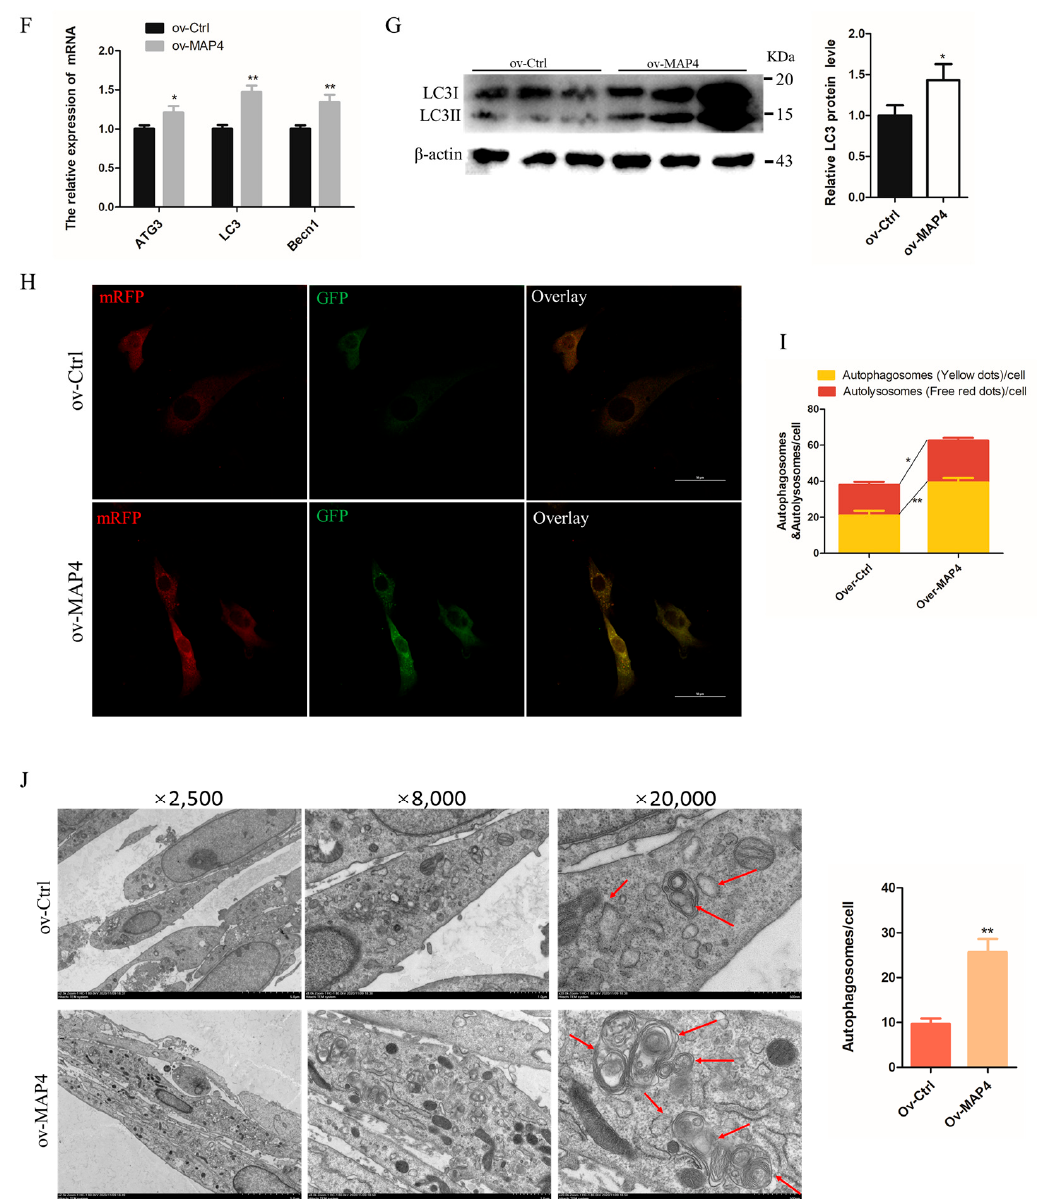
Figure 6. MAP4 induced autophagy of C2C12 cells. ( A , F ) ATG3 , LC3 , and Becn1 expression levels in C2C12 cells were determined at 24 h after MAP4 knockdown or overexpression. n = 3. ( B , G ) The protein expression of LC3 was determined by western blot at 48 h after MAP4 knockdown or overexpression. β -Actin was used as endogenous control. n = 3. ( C , H ) The autophagosomes and autolysosomes in C2C12 cells with MAP4 knockdown or overexpression were observed by confocal microscopy at 24 h after treatment with the mRFP-GFP-LC3B adenovirus. Red fluorescence indicates autolysosomes; green fluorescence indicates lysosome; yellow fluorescence indicates autophago- somes. Scale bar = 50 μ m. n = 3. ( D , I ) Mean numbers of autophagosomes and autolysosomes in overlay images per cell. ( E , J ) Autophagosomes were observed by transmission electron microscopy at 24 h after MAP4 knockdown or overexpression. Red arrows indicate autophagosomes. Magnifi- cation: ×2500 (scale bar = 5 μ m), ×8,000 (scale bar = 1 μ m), and ×20,000 (scale bar = 500 nm). n = 3. * p < 0.05, ** p < 0.01.